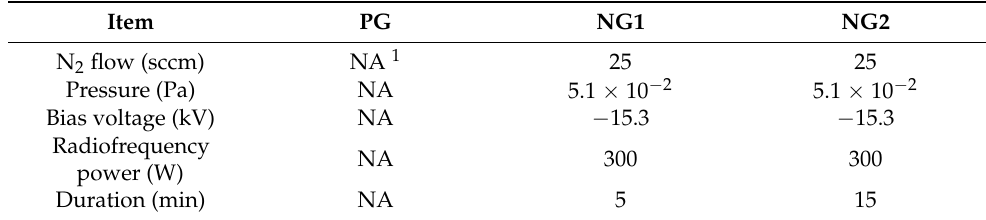
Table 1. Process parameters of N ions